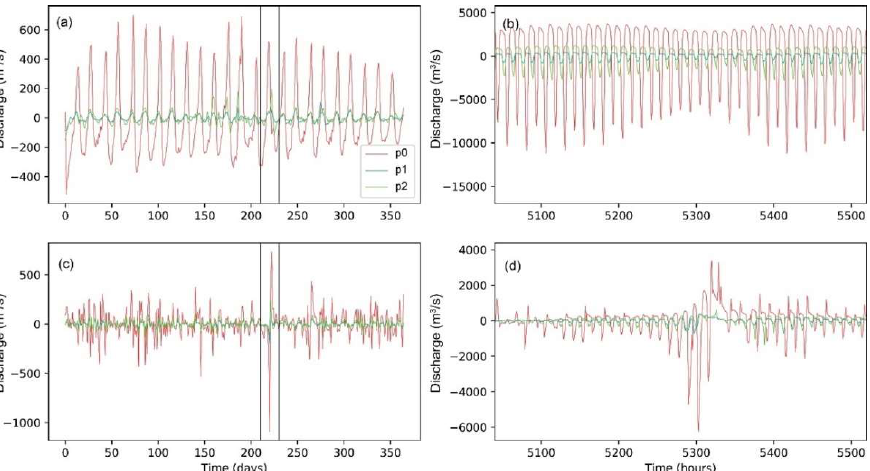
Figure 9. Differences in the river discharge at the three coastal unit catchments. ( a , b ) show the difference between S0 and S1 at the daily and hourly scales, respectively. ( c , d ) show the difference between S2 and S1 at the daily and hourly scales, respectively.